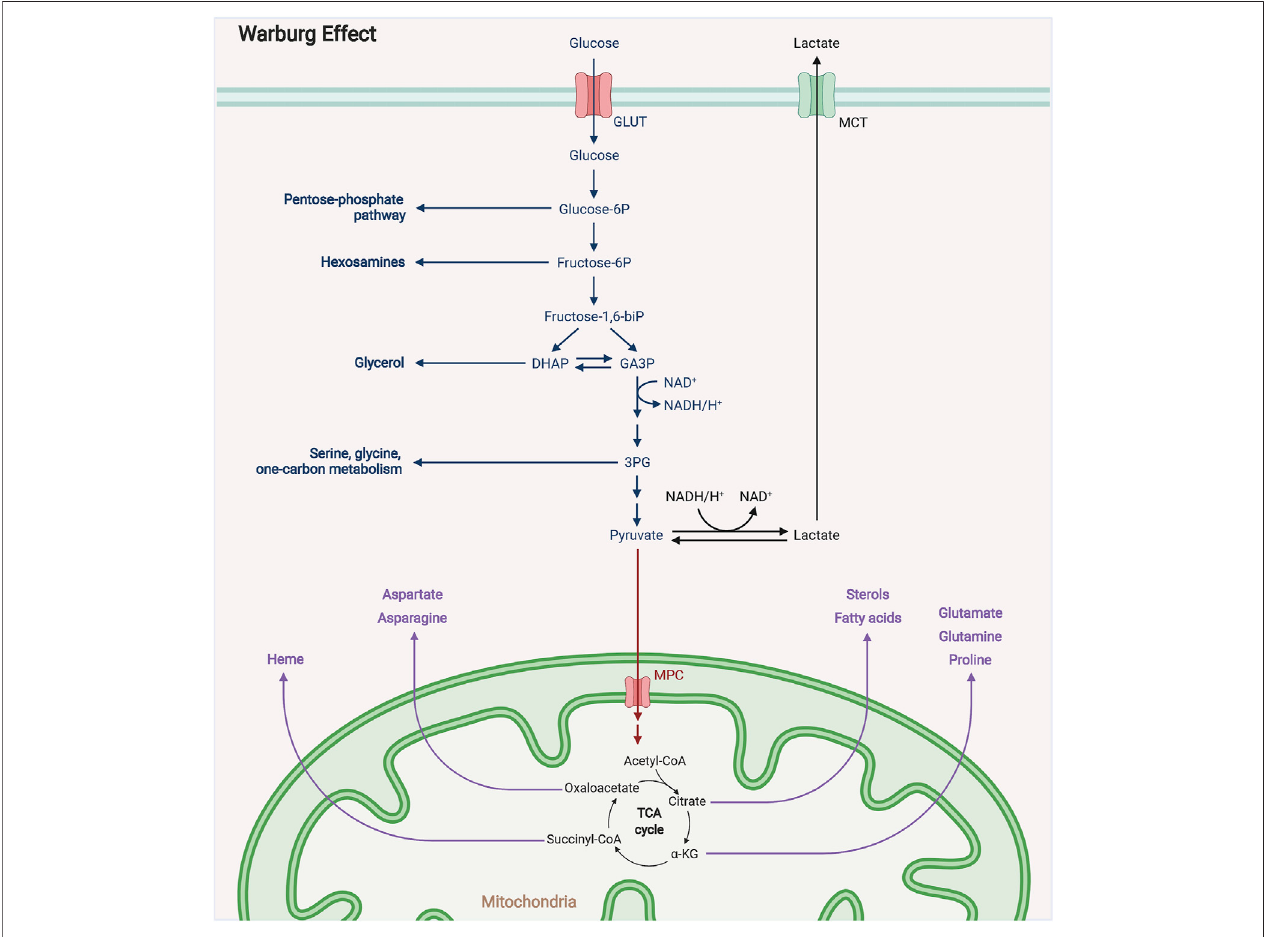
FIGURE1| The mechanism diagram ofWarburgeffect.TheWarburgeffect statesthatinthepresenceofsuf fi cient oxygensupply, tumor cellsstill prefer glycolysis for energy to the more ef fi cient oxidative phosphorylation, a phenomenon known as the Warburg effect.